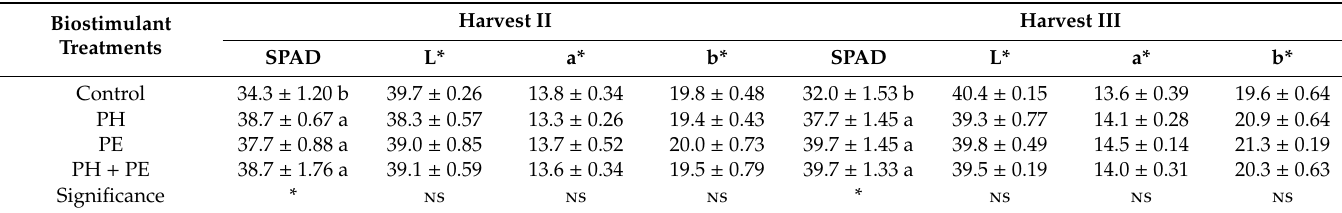
Table 2. E ff ect of foliar applications of protein hydrolysates (PH) and tropical plant extract (PE) alone or in combination on soil plant analysis development (SPAD) index and colorimetric parameters of greenhouse cultivated perennial wall rocket.